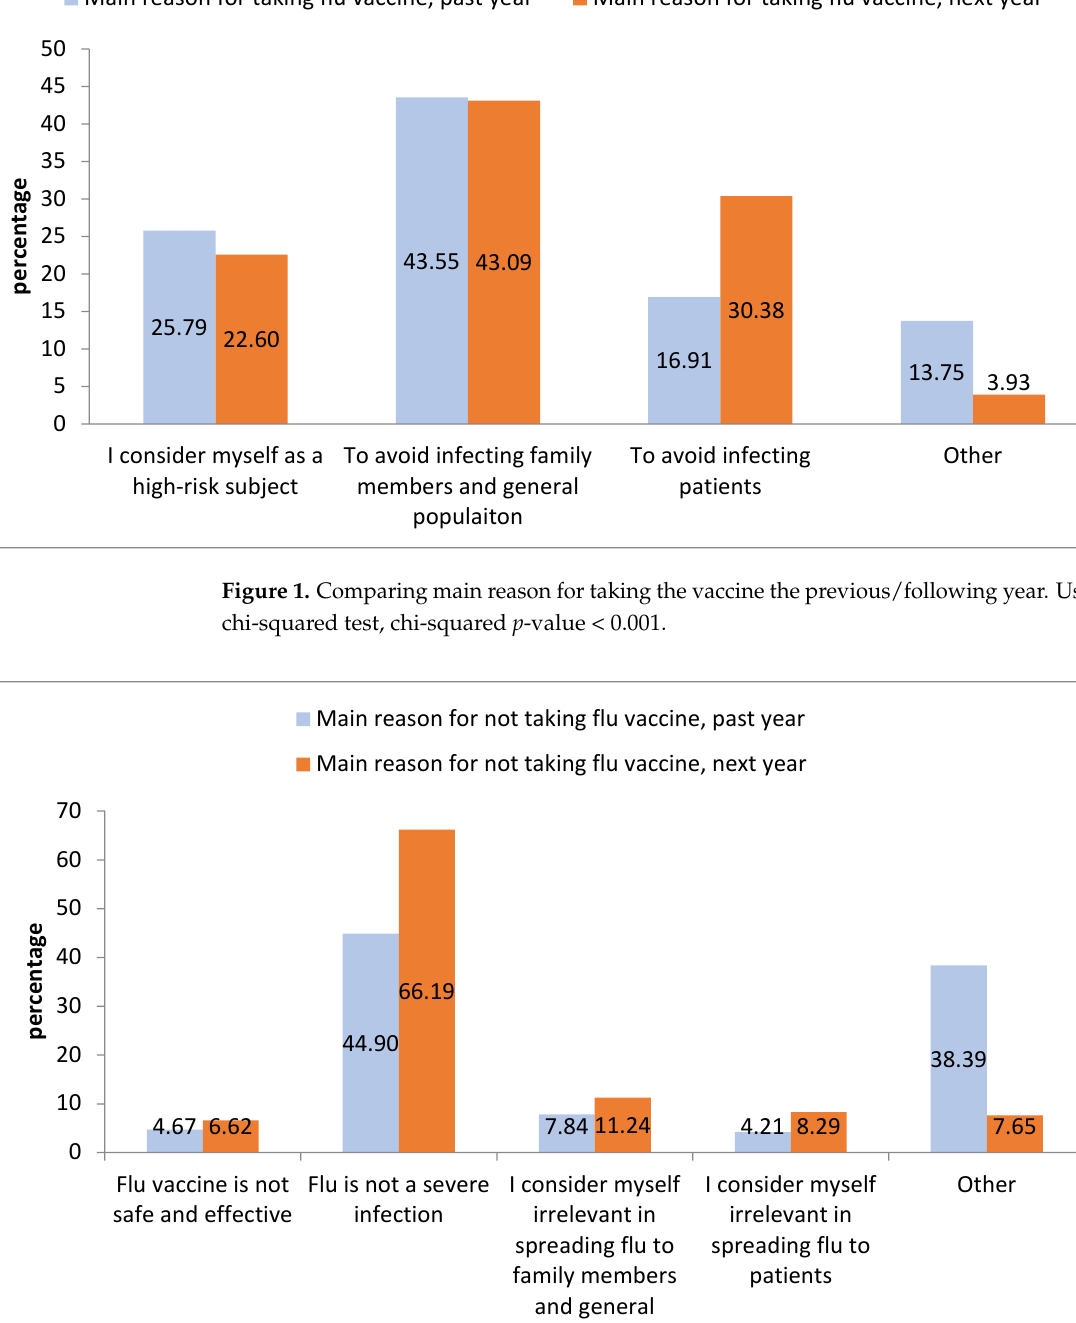
Figure 2. Comparing main reason for not taking influenza vaccine the previous/following year. Used Pearson’s chi-squared test, chi-squared p -value < 0.001.